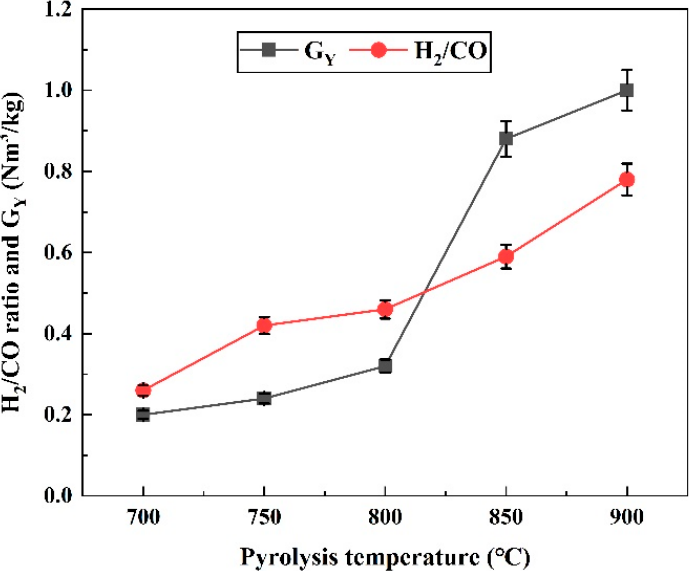
Figure 3. Effect of pyrolysis temperature on H 2 /CO and dry gas yield (G Y ) of pine